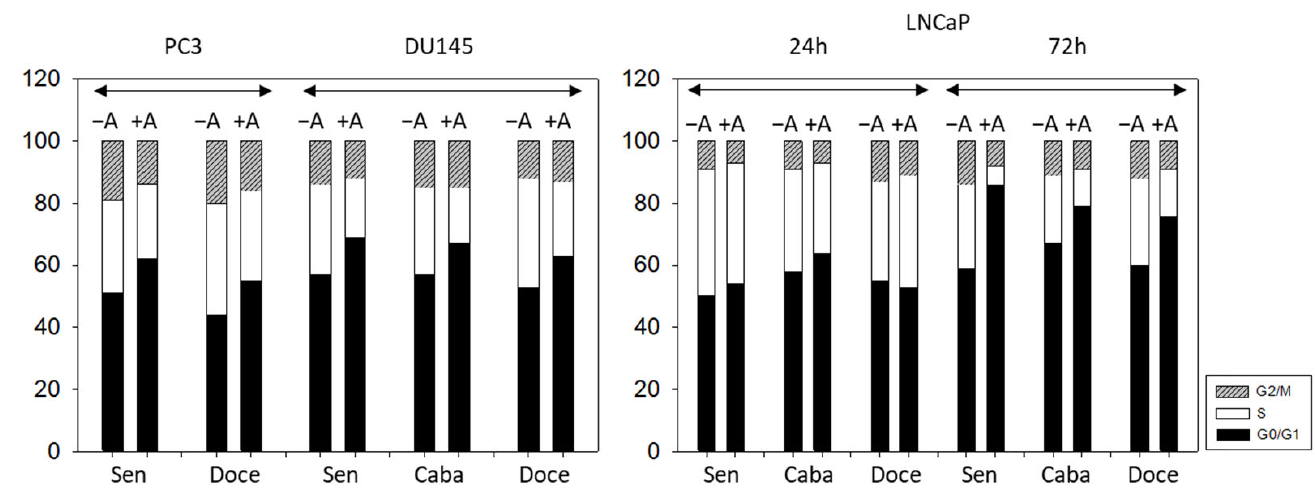
Figure 4. Cell cycle distribution in drug-sensitive and drug-resistant PC3, DU145, and LNCaP cells following amygdalin exposure (+A) for 24 (all cell lines) and 72 h (LNCaP cells). Controls ( − A) remained untreated. One representative of three separate experiments is shown (n =